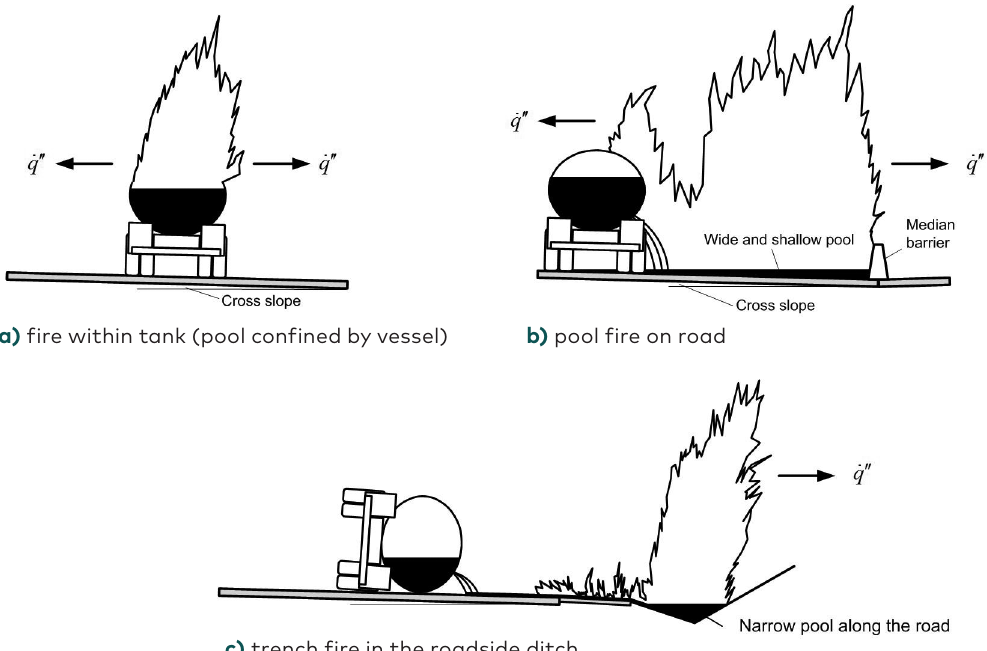
Figure 2. Three types of pool fires caused by ignition of flammable liquid